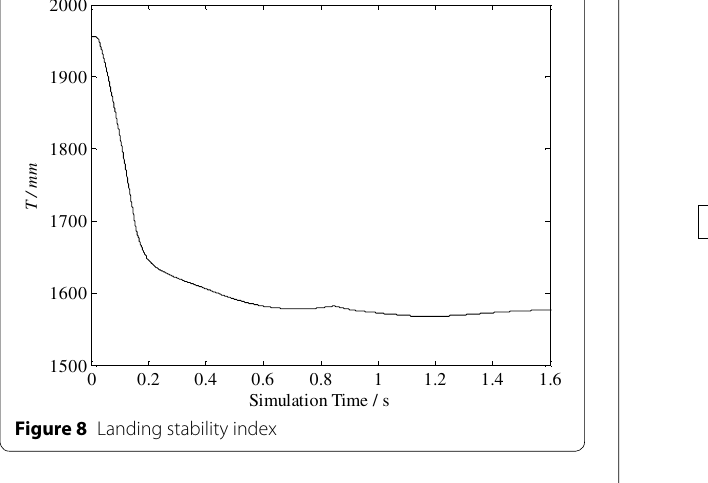
Figure 8 Landing stability index